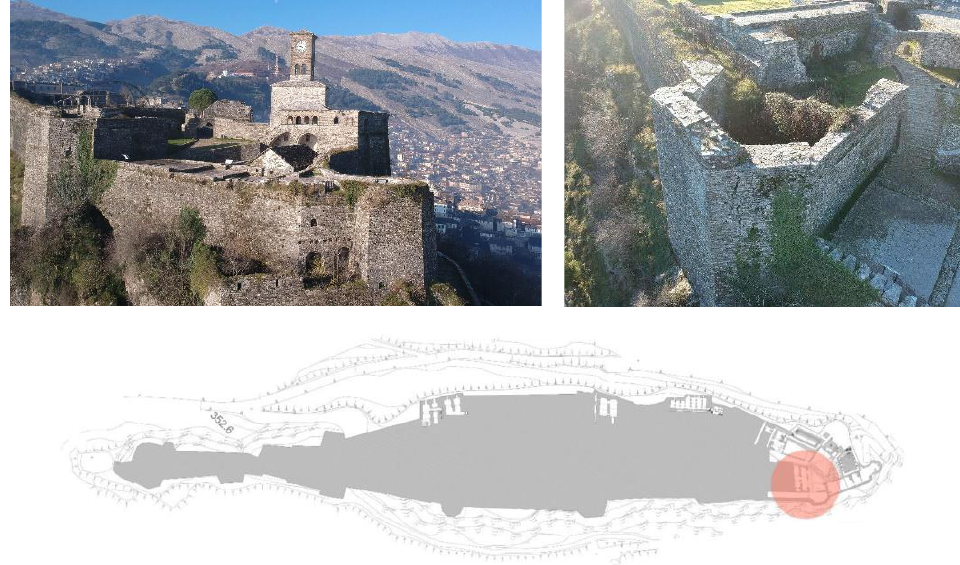
Figure 2. ( Top left ) Aerial view of the north-eastern end of the castle; ( top right ) aerial view of the tower under investigation and location of tower in the fortress, marked with an orange circle ( bottom ) (Photo credit: Rand Eppich).